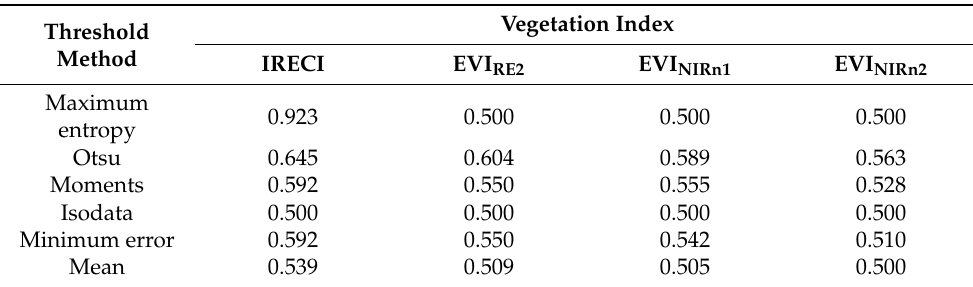
Table 5. Comparison of the accuracies of various vegetation indices and threshold determination method combinations.